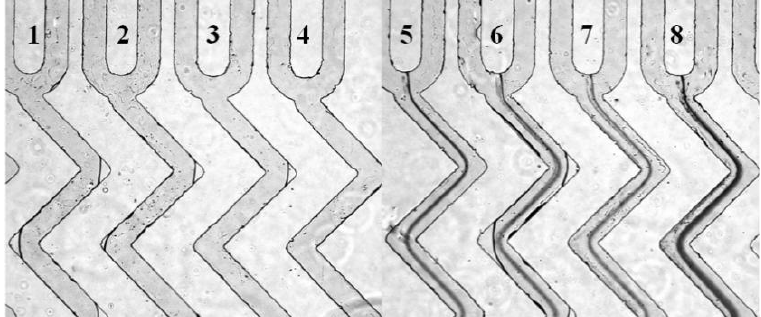
Figure 6. Image taken by a camera through a drop of water on a microfluidic